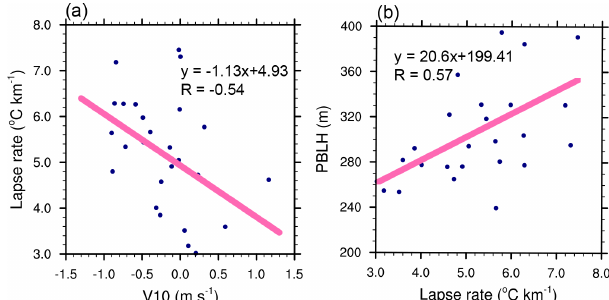
Figure 11. Scatterplots of the correlations between the (a) 10m meridional wind speed (positive – southerly wind; negative – northerly wind) and lapse rate within 1.5km and (b) the lapse rate within 1.5km and PBLH. The data are daily averages from 3 to